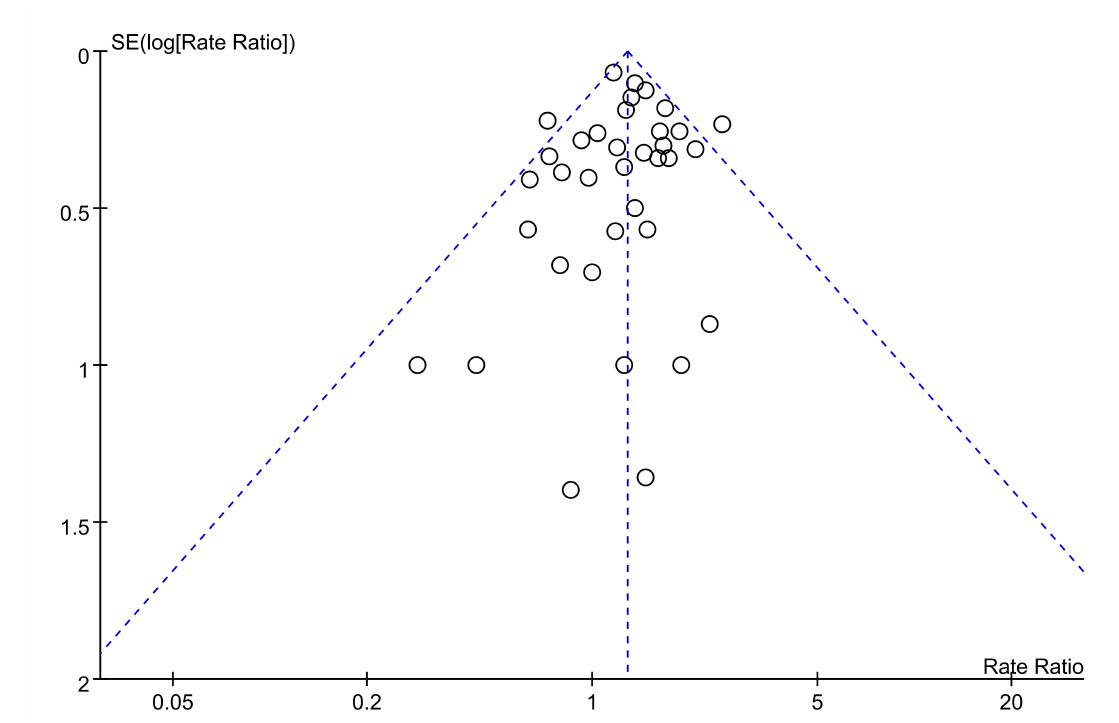
Figure 3. Funnel plot of log-transformed standardized mortality ratios (SMRs) of asbestos exposure and esophageal cancer and standard errors for the 33